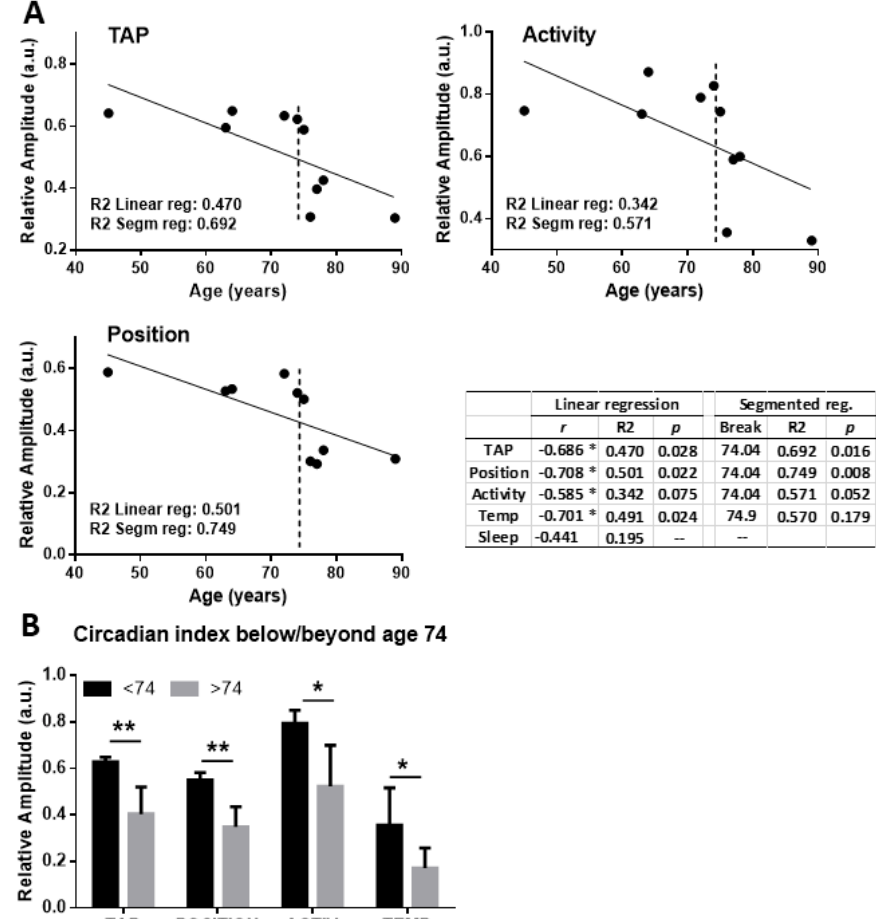
Figure 2. Aging is correlated with a decay in the marker circadian rhythms in humans. ( A ) Correlation between age and the Relative Amplitude (RA) of TAP, activity and position ambulatory rhythms in 10 individuals. The table shows the Pearson coe ffi cient of correlation (r, where * p < 0.05) and the coe ffi cient of determination (R2) and the level of significance ( p ) for both linear and segmented regression models. Column “ Break ” states the break point of the segmented model (indicated by a dashed line in the graphs). ( B ) Histograms showing a statistically significant di ff erence in the RA index for the four main circadian variables before vs after 74 years age (* p < 0.05, ** p < 0.01, – not significant). n = 10 individuals.